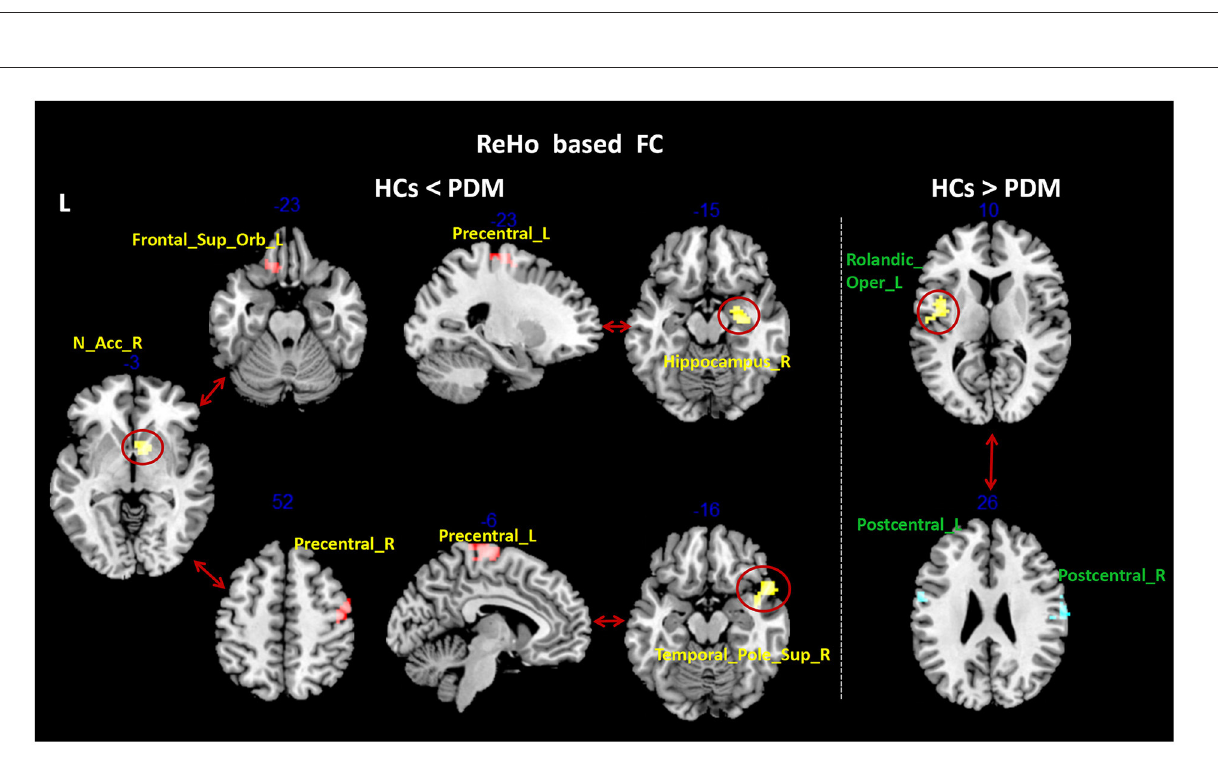
FIGURE3 Group differences in ReHo-based FC between patients with PDM and HCs (voxel threshold: uncorr. p < 0.001, cluster threshold: p -FWE < 0.05). Patients with PDM showed enhanced FC between the right hippocampus and the left precentral gyrus, the right nucleus accumbens and the left supraorbital frontal gyrus and the right precentral gyrus, the right temporal pole superior temporal gyrus and the left precentral gyrus; and weakened FC between the left rolandic operculum and bilateral postcentral gyrus. PDM, patients with primary dysmenorrhea; HCs, healthy controls; FWE, family-wise error; ReHo, regional homogeneity; FC, functional